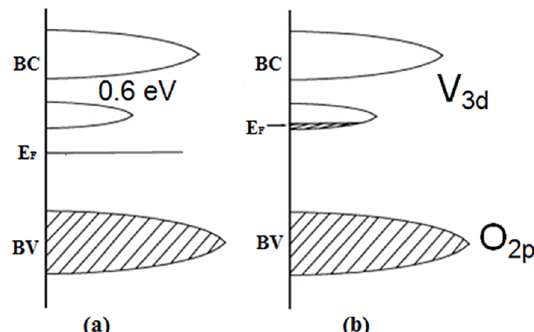
O thin films with different 2 5